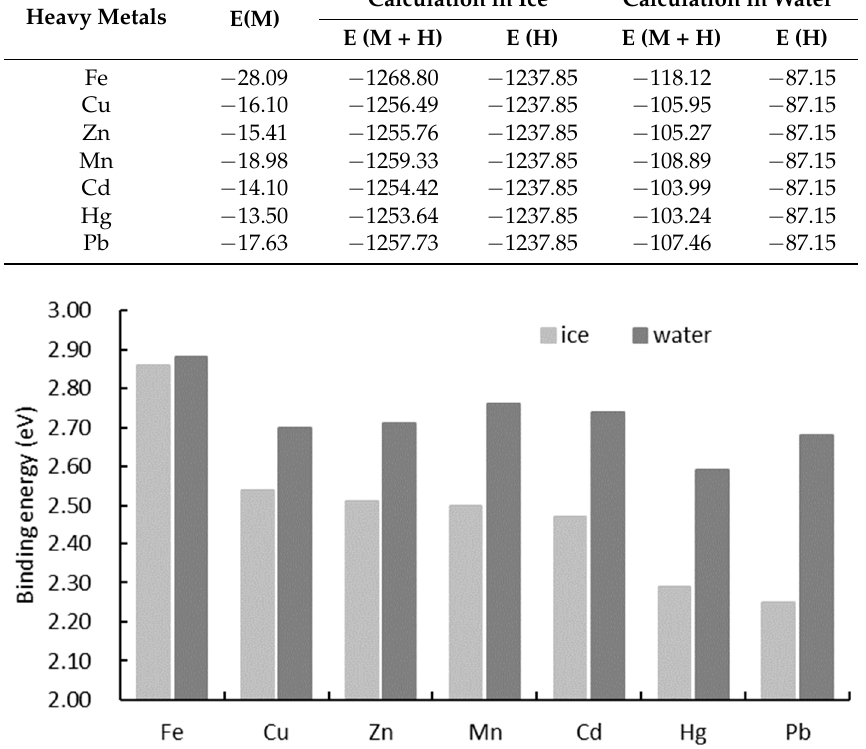
Figure 4. Binding energies of HMIs in ice and water.